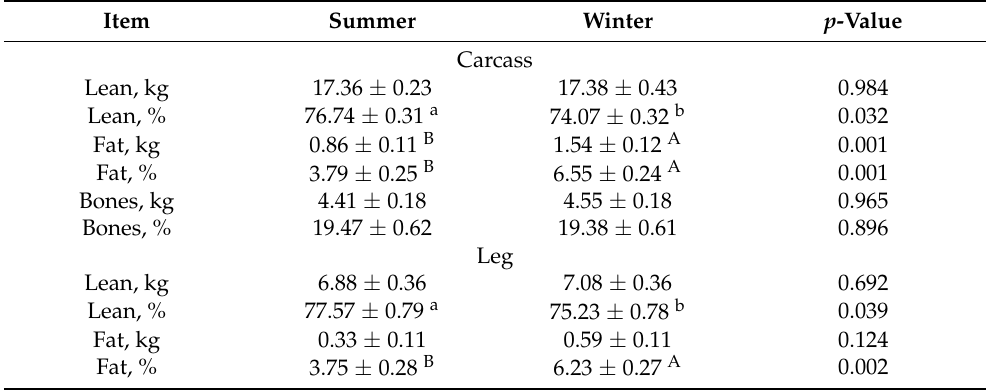
Table 4. Seasonal variation in the composition of carcass and carcass cuts.(LSM ± SE).